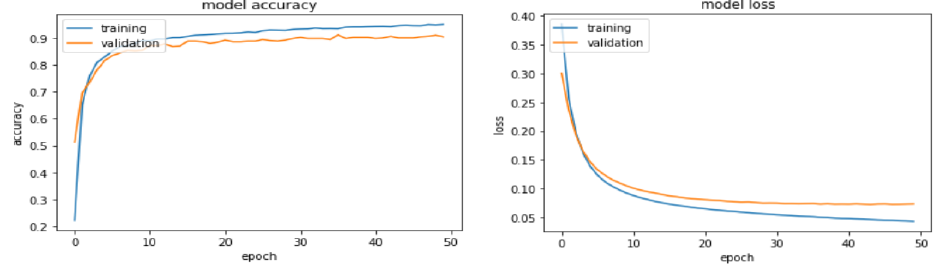
Figure 20. Model accuracy and loss plots for the SYSU 3D HOI dataset.